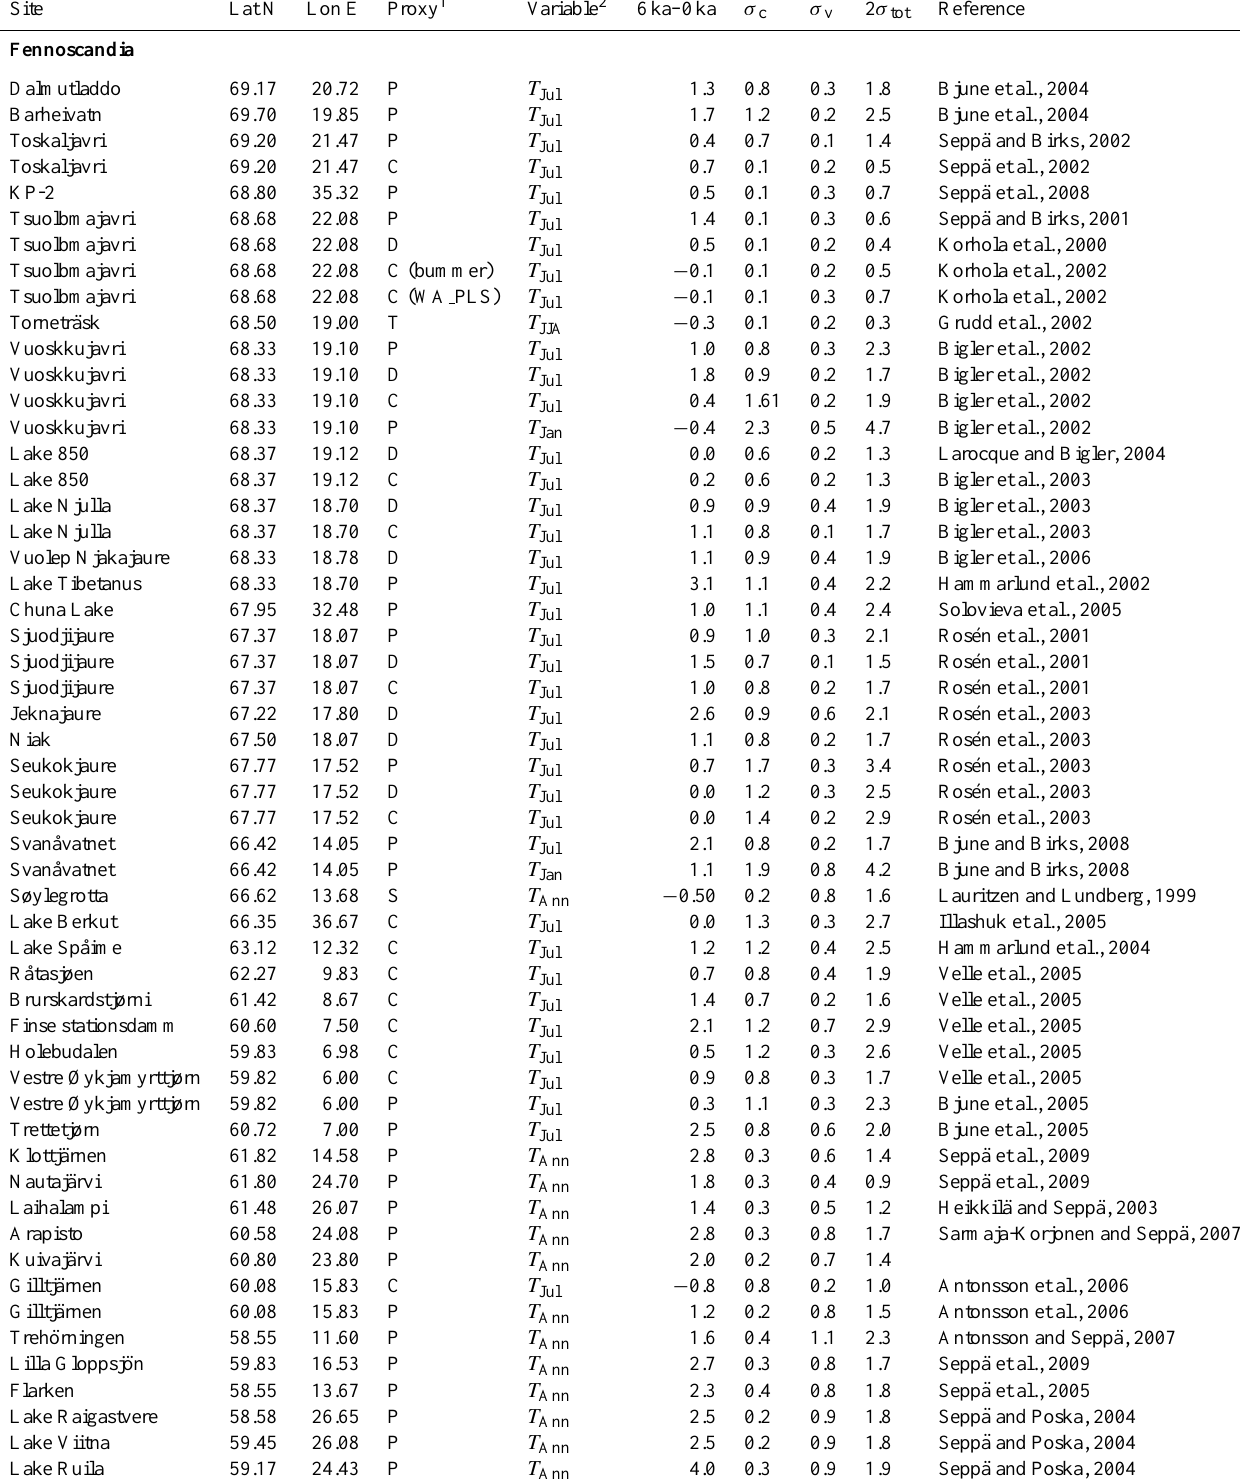
Table 1a. Temperature reconstructions from proxy data discussed in this